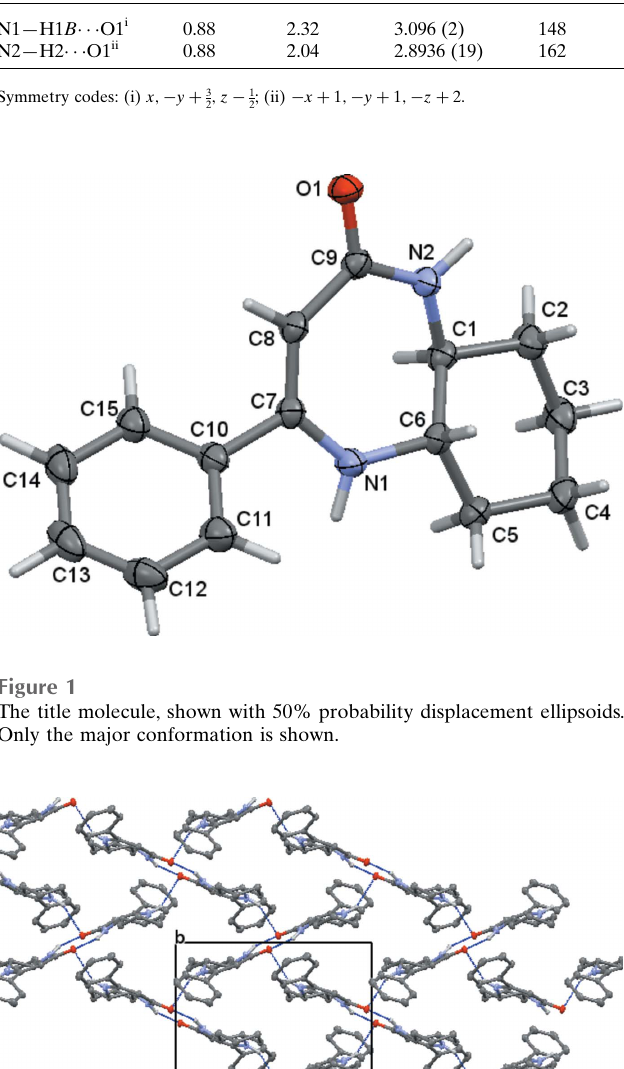
Table 2 Experimental details. Crystal data Chemical formula